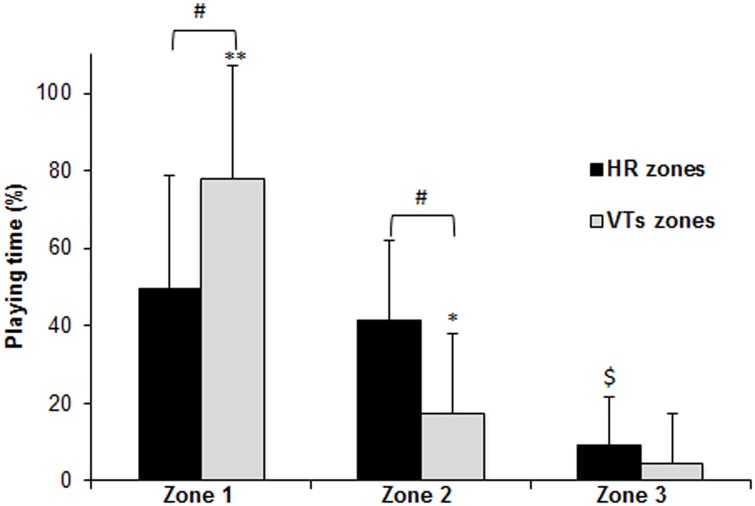
Comparison of playing time (%) spent in the three differentiated intensity zones.Intensity zones defined by the VTs zones method (below VT1 (Zone 1), between VT1 and VT2) (Zone 2), and over VT2 (Zone 3)) and defined by the HR zones method (below 70% HRmax (Zone 1), between 70 and 85% HRmax (Zone 2), and over 85% HRmax (Zone 3)). Mean ± SD values and standard deviations. **p < 0.001 for VTs zone 1 vs both VTs zones 2 and 3; *p < 0.05 for VTs zone 2 vs VTs zone 3. $ p < 0.001 for HR zone 3 vs both HR zones 1 and 2. # p < 0.001 for HR vs VTs zones 1 and 2.